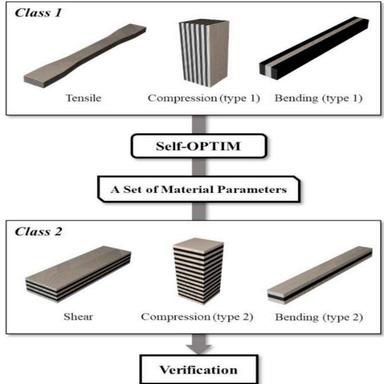
Inverse identification and verification test procedures for Cf/SiCm using Self-OPTIM.